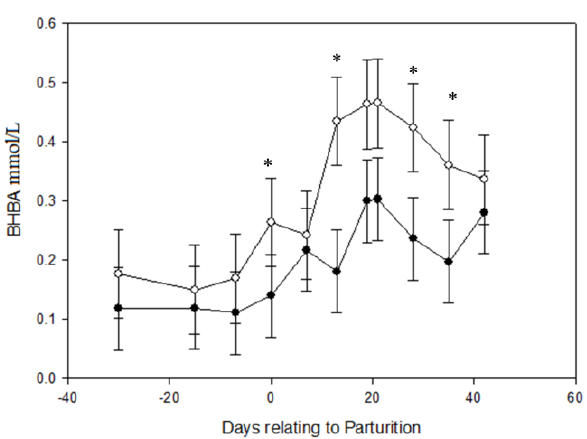
Figure 1. Least square of means values and standard errors for serum BHBA (mmol/L) concentration at 30 d before parturition till 42 d in milk in Saanen goats receiving monensin (●), and not receiving monensin (○). Significant time  treatment interactions (p<0.05) on d 1, 13, 28 and 35 were showed by an asterisk.